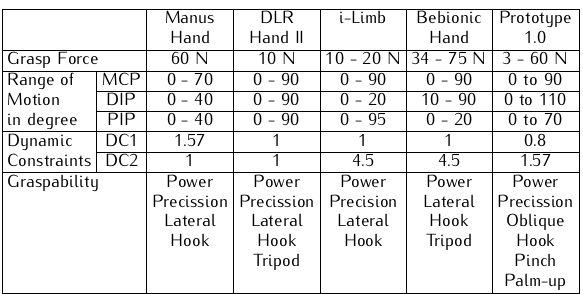
Figure 11. Desired and Actual Fingertip Contact Force with K p = 200, K i = 100 and K d = 10